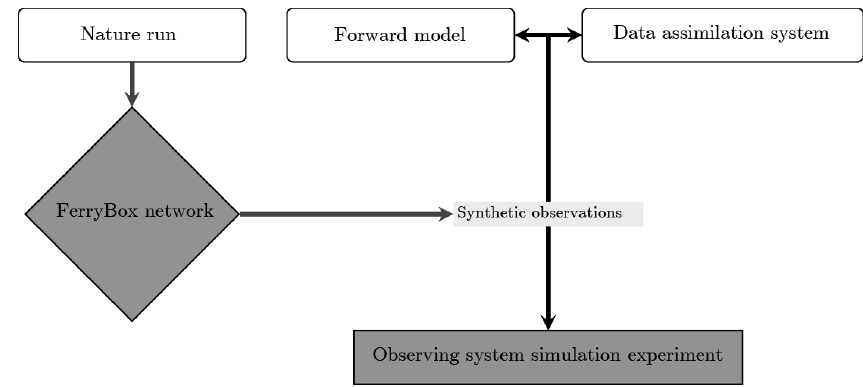
Figure 2. OSSE methodology applied in the Turkish Straits System. The forward model (FM) is a different configuration of the model setup used for the nature run (NR) as detailed in the text.